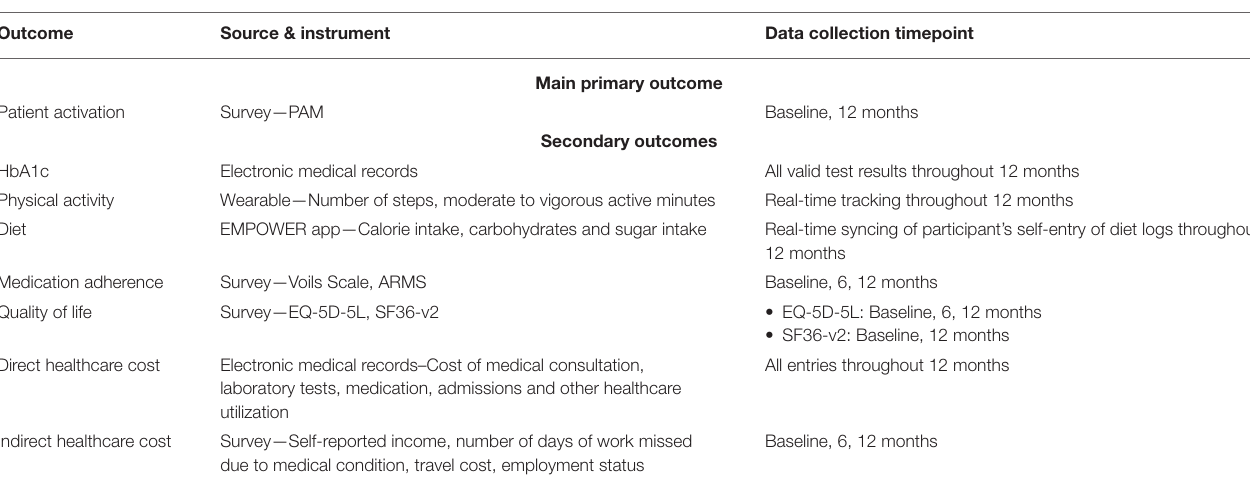
TABLE 2 | Primary and secondary